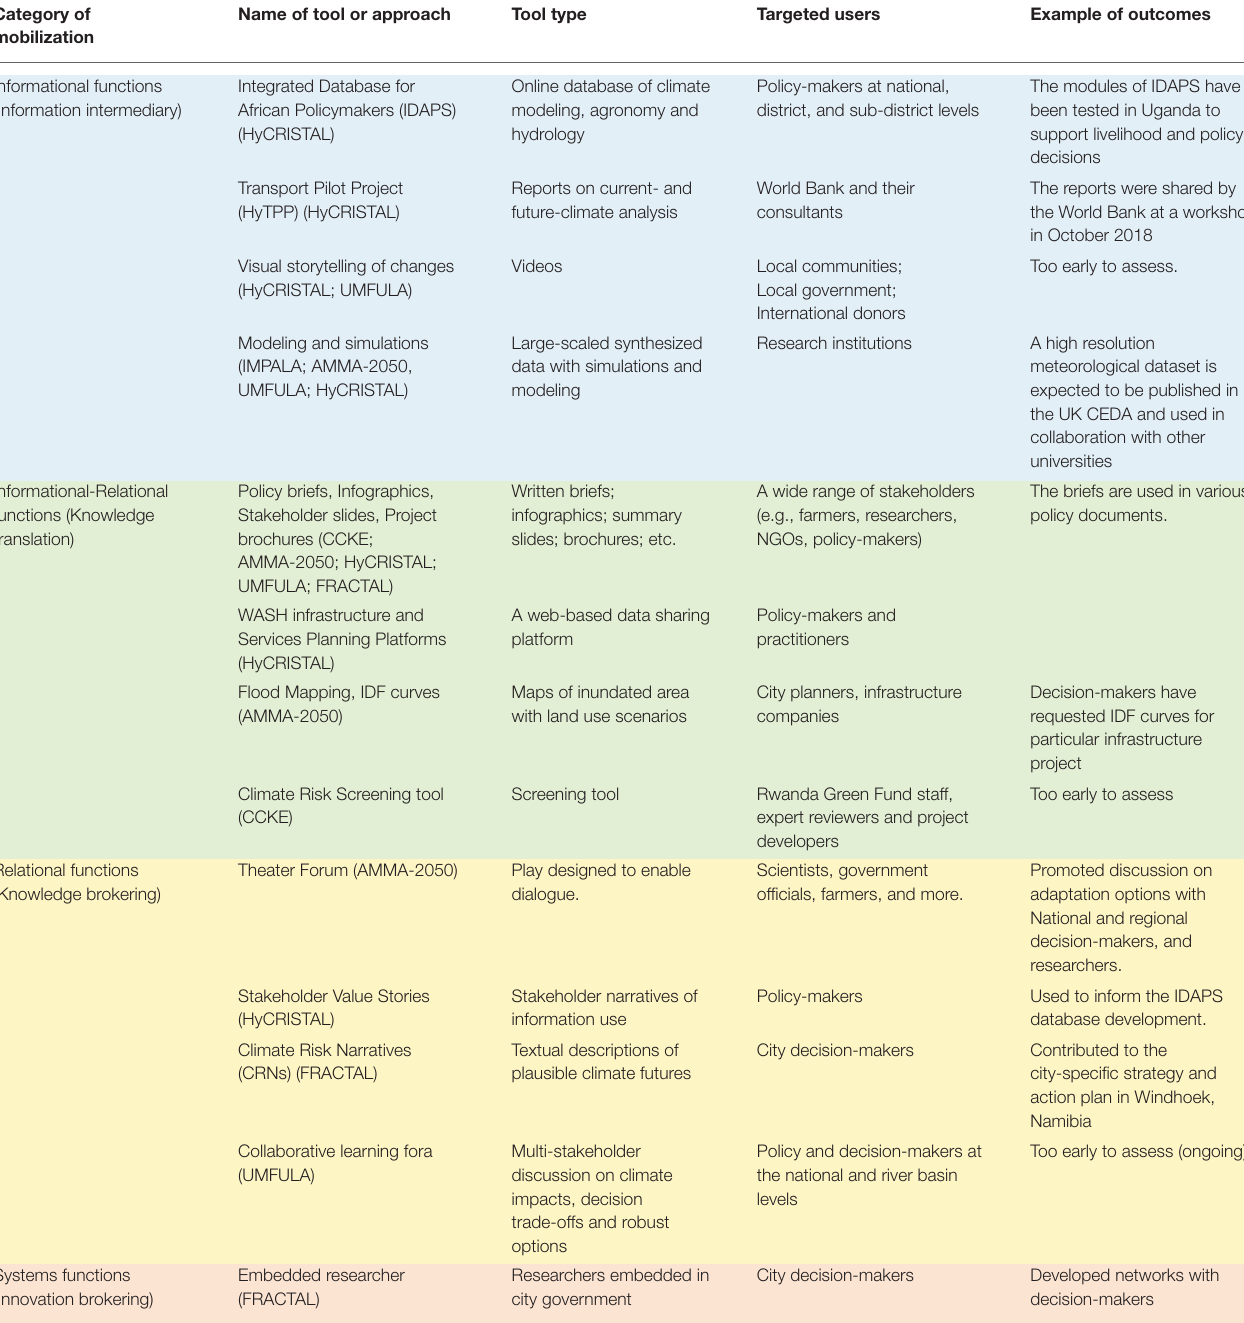
TABLE 3 | Tools and approaches to knowledge mobilization and uptake by targeted